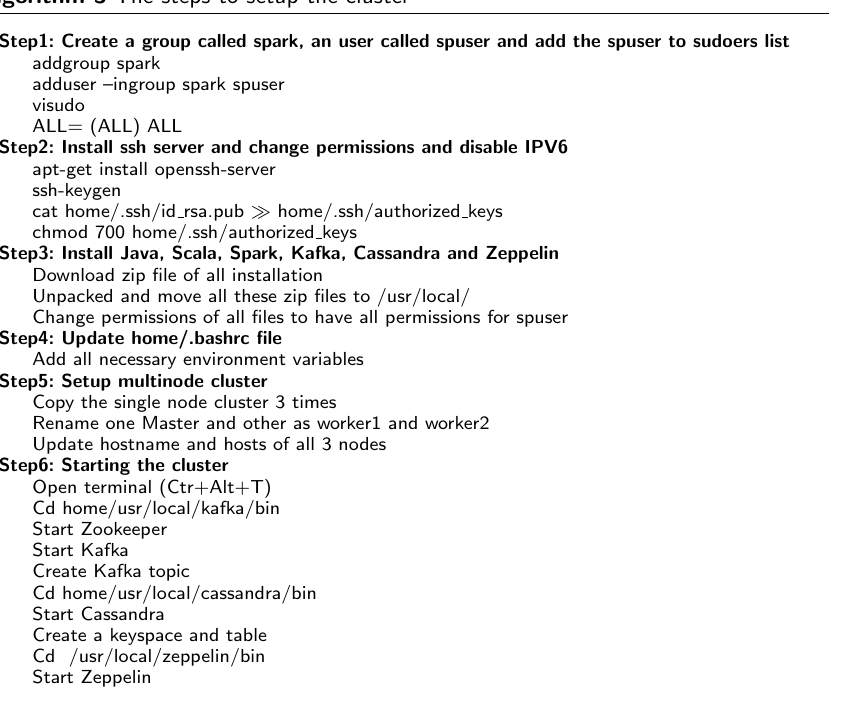
Algorithm 3 The steps to setup the cluster